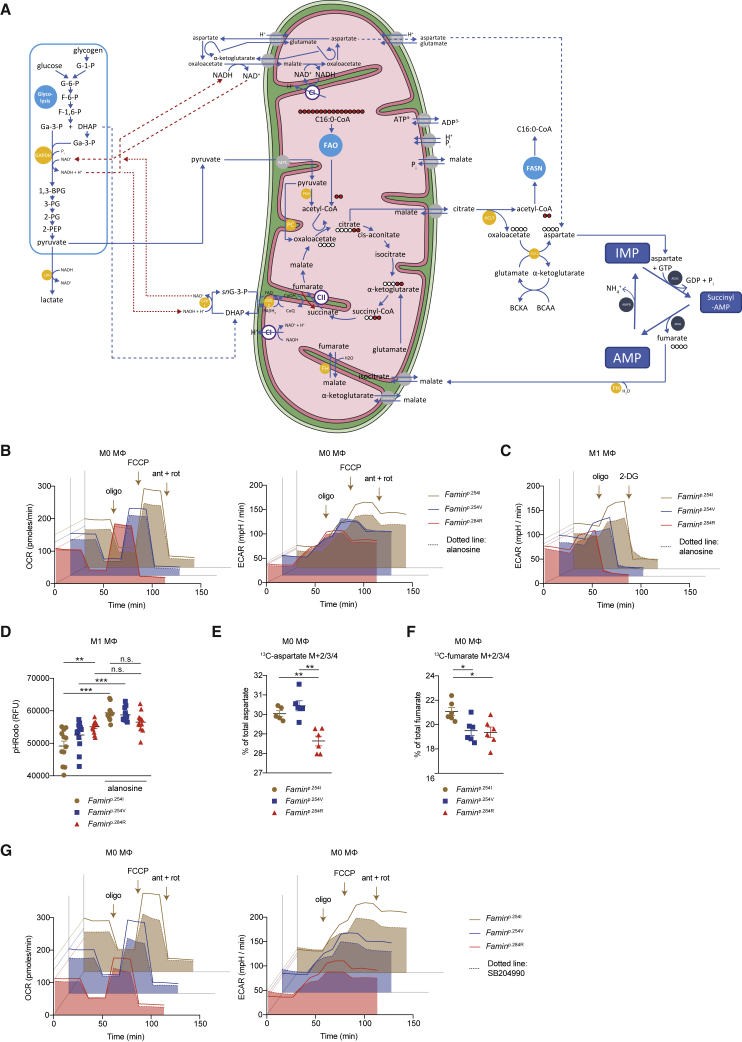
A FAMIN-Dependent PNC Controls Energy Metabolism(A) Schematic of cellular energy metabolism in context of the PNC. PNC enzymes (blue circles), other enzymes (yellow circles), and transporters (gray circles) with gene names. Electron transfer from glycolysis to mitochondria by the glycerol-3-phosphate (G3PS; connected with red dotted lines) and malate-aspartate shuttle (MAS; connected with red dashed lines). Filled red circles depict fate of [13C16] palmitic acid (C16:0)-derived carbons through fatty acid oxidation (FAO) into tricarboxylic acid (TCA) cycle citrate and by ATP citrate lyase (ACLY) into fatty acid synthesis (FASN); empty circles depict route of carbons from TCA oxaloacetate; labeling of α-ketoglutarate and succinyl-CoA depicted for M0 macrophages with intact TCA cycle. Complex II (CII) forward and reverse activity, blue and red arrowed arcs, respectively. CoQ, coenzyme Q; CI, complex I; branched chain amino and keto acids (BCAA, BCKA); DHAP, dihydroxyacetone phosphate; G-6-P, glucose-6-phosphate; F-6-P, fructose-6-phosphate; F-1,6-P, fructose-1,6-bisphosphate; Ga-3-P, glyceraldehyde-3-phosphate; 1,3-BPG, 1,3-bis-phosphoglycerate; 3-PG, 3-phosphoglycerate; 2-PG, 2-phosphoglycerate; 2-PEP, 2-phosphoenolpyruvate.(B) OCR (left) and ECAR (right) of M0 macrophages treated (dotted line + fill) with L-alanosine for 3 h or vehicle (solid line). Basal OCR and ECAR followed by (arrows) oligomycin A (Oligo), FCCP, and rotenone plus antimycin A (Rot + ant) (n = 3).(C) ECAR of M1 macrophages treated (dotted line + fill) with L-alanosine or vehicle (solid line). Basal ECAR followed by (arrows) Oligo and 2-deoxyglucose (2-DG) (n = 3).(D) Cytoplasmic pH (pHc) measured using pHrodo in M1 macrophages treated with L-alanosine or vehicle (n = 12 from 3 mice per genotype).(E and F) Fraction of aspartate (E) or fumarate (F) labeled as the indicated isotopomer in M0 macrophages after a [13C16] palmitate pulse (n = 6). (G) OCR (left) and ECAR (right) of M0 macrophages treated (dotted line + fill) with SB204990 (ACLY inhibitor) or vehicle (solid line). (n = 3).Data represented as mean ± SEM. ∗p < 0.05, ∗∗p < 0.01, and ∗∗∗p < 0.001 (one-way ANOVA).